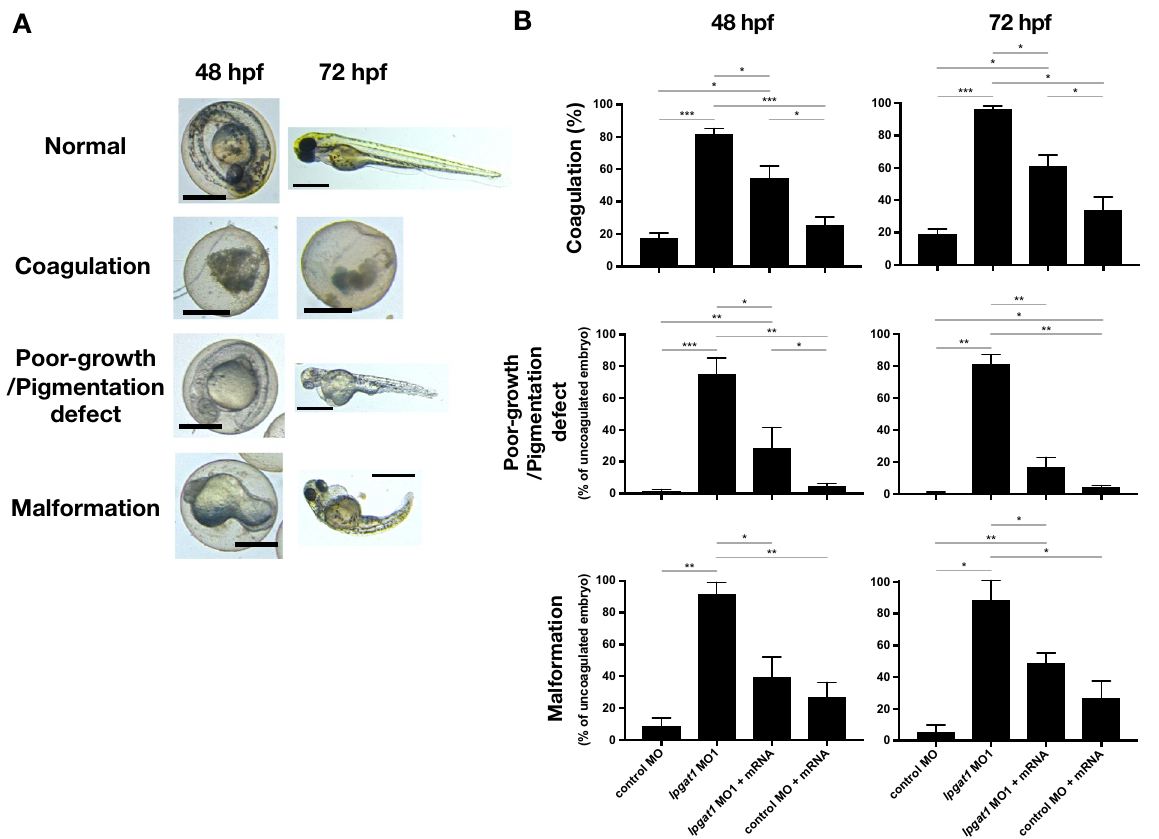
Figure 5. Downregulation of lpgat1 induced various embryonic developmental defects using morpholino oligonucleotides (MO). Each of embryos injected with MOs were observed overtime by time-lapse imaging. ( A ) The representative images of the normal embryos and larva, coagulated eggs, embryos and larva with poor- growth/pigmentation defect, and malformed embryo (with bent body axis, short body length and/or edema). LAS software (Ver. 4.12, Leica) was used to process the images. hpf; hours post fertilization. Scale bar, 500 µm. ( B ) Upper graphs, percentage of coagulated eggs after injection of morpholino antisense oligo (MO) specific to lpgat1 (MO1) or control MO (cMO) in combination with lpgat1 mRNA. MO1 is a splicing inhibitor, which bind to the exon–intron junction of immature lpgat1 mRNA and inhibit the splicing of pre-mRNA. Middle graphs, percentage of pigmentation defect and bottom graphs, malformation in uncoagulated embryos. Basically, the same results were obtained as shown in Fig. S9B using morpholino oligonucleotides 2 (MO2). The means of the data from three independent experiments for each group with n = 200 in total are shown. Error bars are S.D. Statistically significant differences are marked with asterisk. * p < 0.05; ** p < 0.01, *** p < 0.001. Two-way ANOVA, Holm’s multiple comparison test was